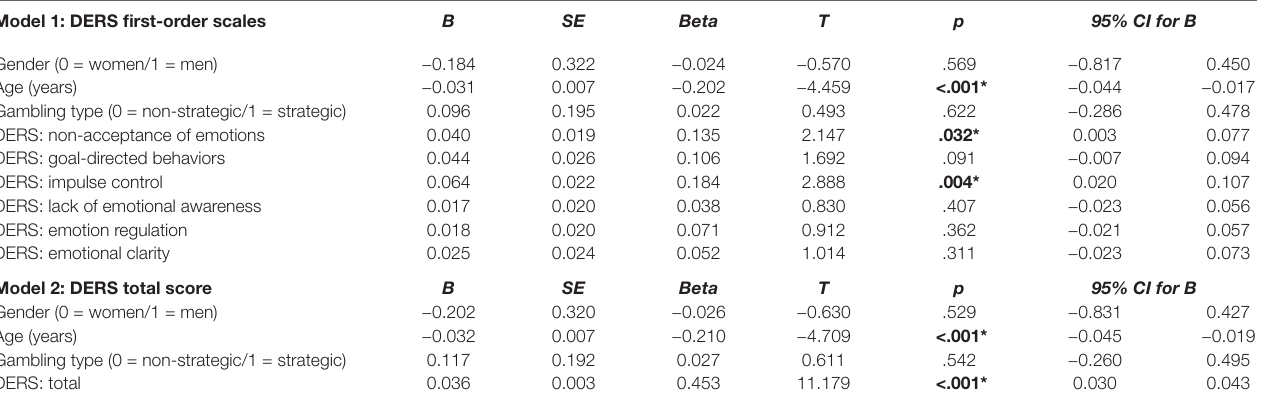
TABLE 3 | Predictive capacity of emotion regulation on gambling severity (DSM-5 total criteria). Model 1: DERS first-order